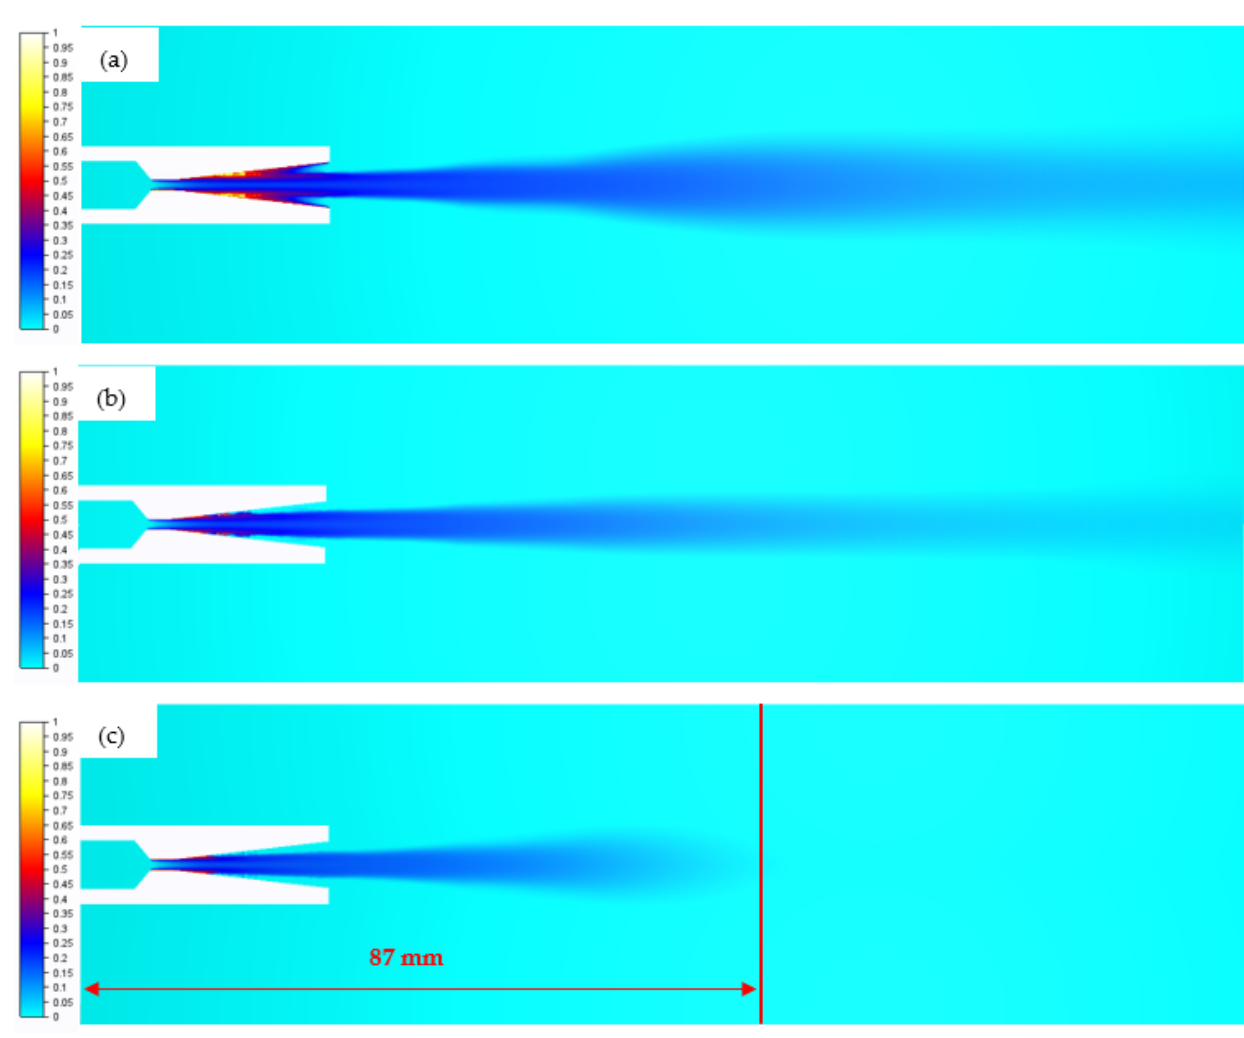
Figure 8. Cavitation vapor volume fraction for cavitation nozzle. P in = 300 atm: ( a ) P out = 0 (gauge), ( b ) P out = 10 atm (gauge), ( c ) P out = 30 atm (gauge).